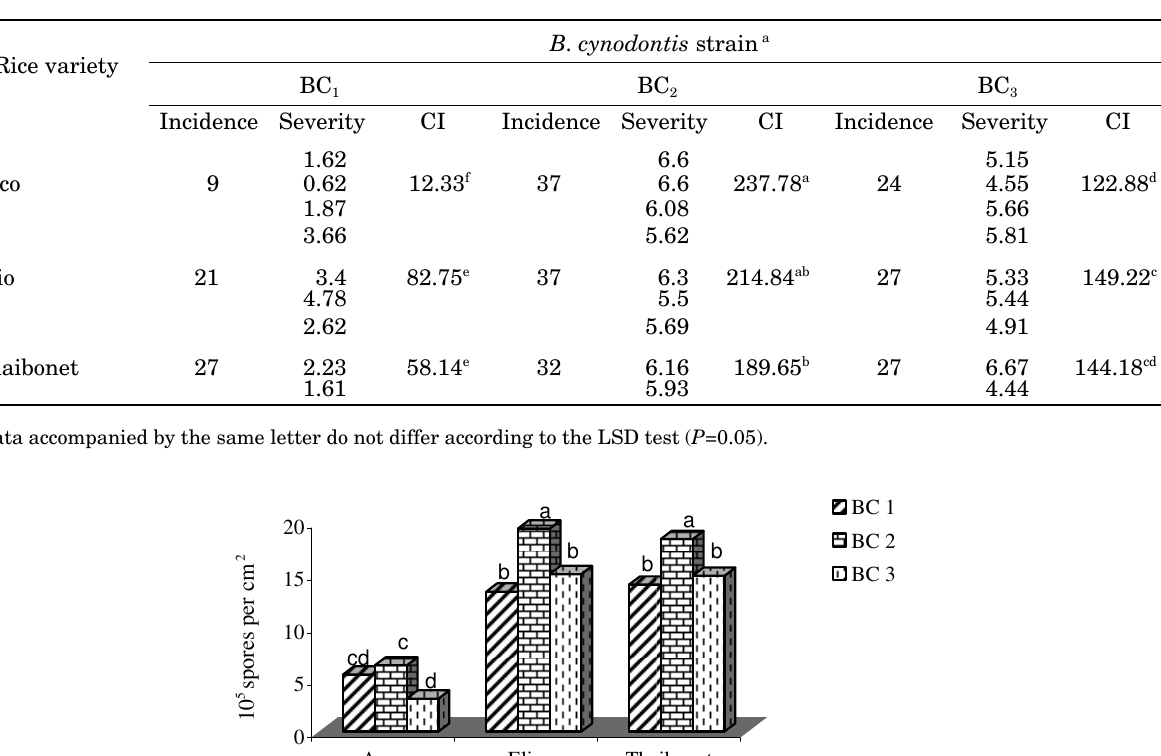
Fig 2. Brown spot symptoms on leaves of Oryza sativa ino- culated with a conidial suspension of Bipolaris cynodontis Table 1. Virulence of three strains of Bipolaris cynodontis on three rice varieties, estimated as the coef fi cient of infec- tion (CI) seven days after inoculation.